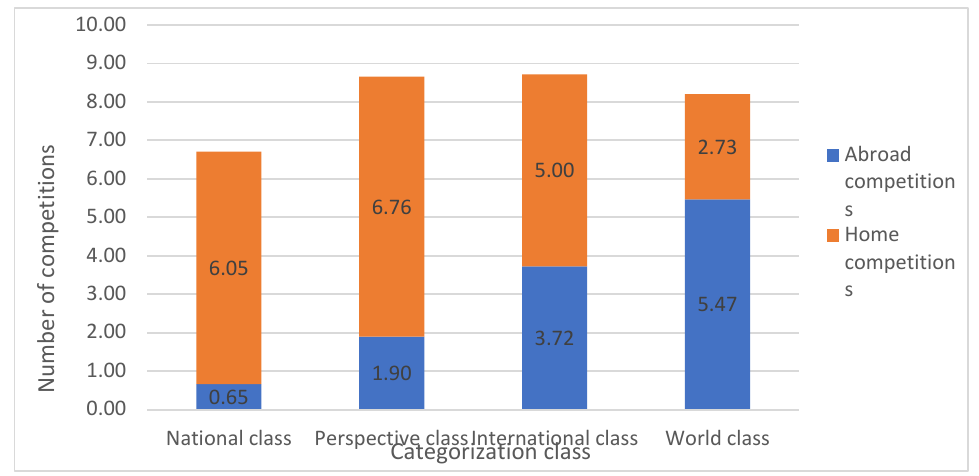
Figure 4. Volume and structure of average total competitions in 5 years per level of categorisation. Table 2 presents the dropout of judo athletes that stopped competing after 10 years.